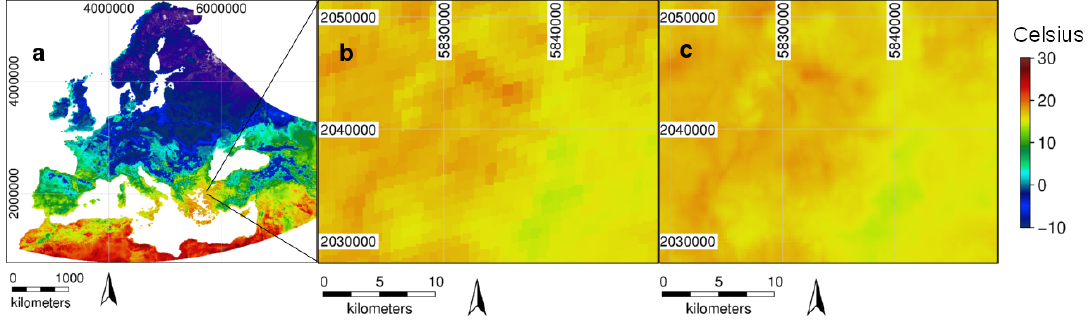
Table 2. List of publicly available datasets derived from reconstructed MODIS